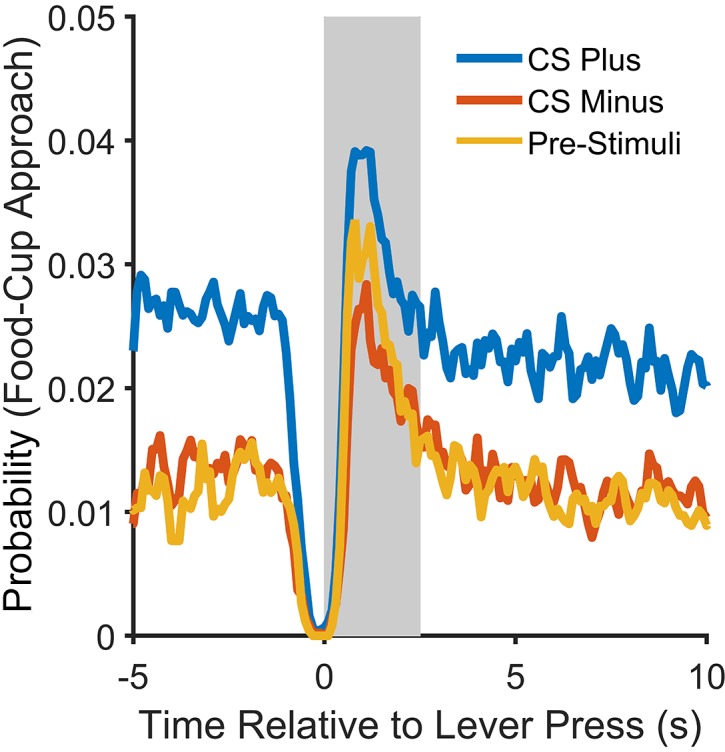
Probability of food-cup approaches as a function of time surrounding individual lever-press responses during PIT testing, plotted separately for CS+ (blue), CS- (red), and pre-CS (yellow) periods.This analysis was restricted to vehicle tests completed by rats in Experiments 2 and 3A. Shewhart process control chart analyses were used to determine the times when food-cup approach behavior was elevated with respect to constant background rates. This value approximated 2.5 s following each lever press, as shown by the shaded box.